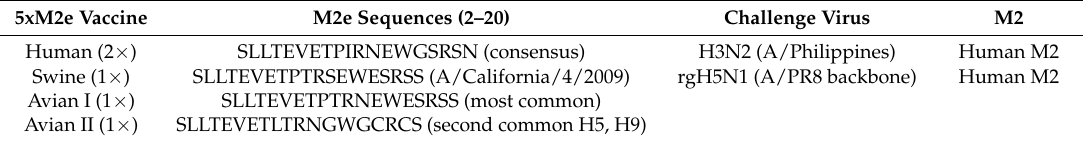
Table 1. The 5xM2e sequence and challenge